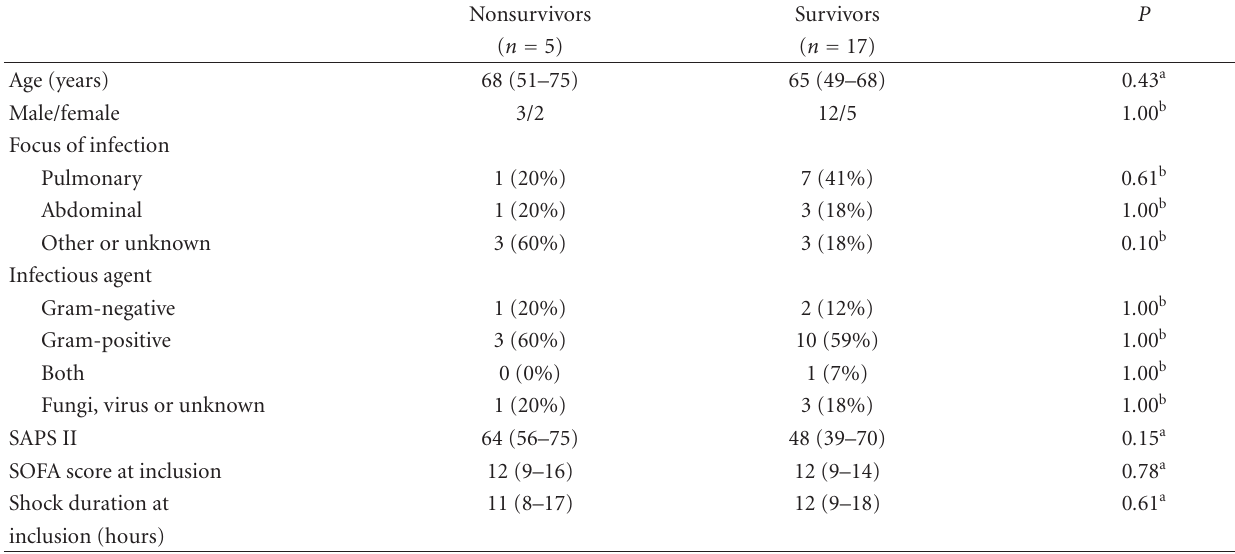
Table 1: Characteristics of 22 septic shock patients. Medians (25th–75th percentiles) or numbers